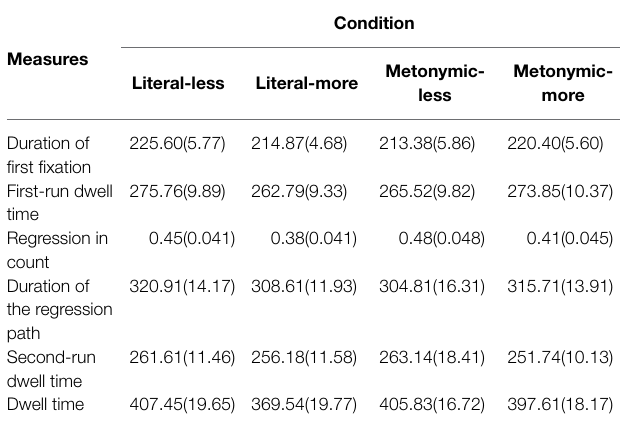
TABLE 1 | Mean reading times and standard errors for the target